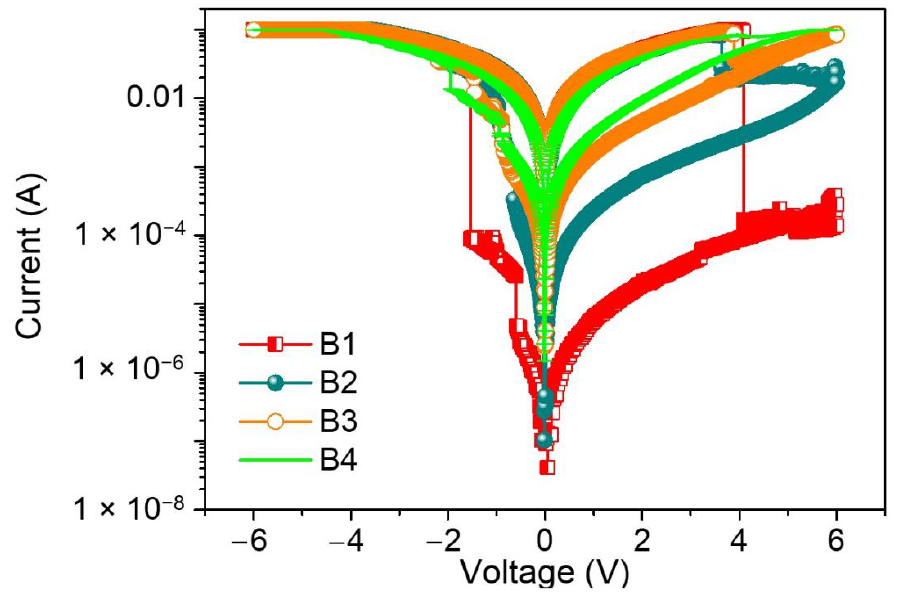
Figure 7. Current–voltage (I–V) characteristics of ITO/B1/Ni, ITO/B2/Ni, ITO/B3/Ni, and Figure 7. Current – voltage (I – V) characteristics of ITO/B1/Ni, ITO/B2/Ni, ITO/B3/Ni, and ITO/B4/Ni.